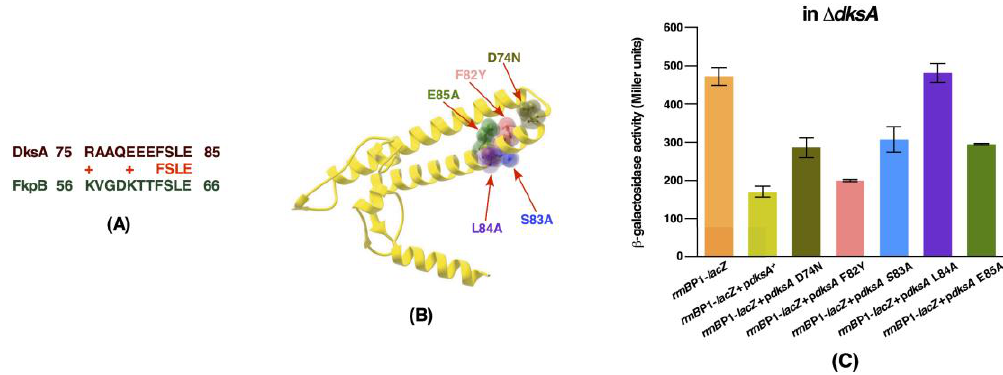
Figure 10. Mutational analysis of amino acid residues critical for the DksA PPIase activity and impact on the transcriptional activity of the rrnB P1 promoter. ( A ) Alignment of conserved amino acid residues of DksA and FkpB. ( B ) The position of amino acid residues that were mutated mapping to the coiled-coil tip and adjacent residues in the structure of DksA (PDB 1TJL). ( C ) Measurement of the β -galactosidase activity from a single-copy chromosomal rrnB P1- lacZ fusion in ∆ dksA derivatives with either the vector alone or its isogenic strains transformed with either the plasmid carrying the wild-type dksA gene or plasmids with dksA variants. Data are presented from a representative experiment with cultures sampled at OD 600 4.0 in the stationary phase. Error bars represent a S.E. of three independent measurements.